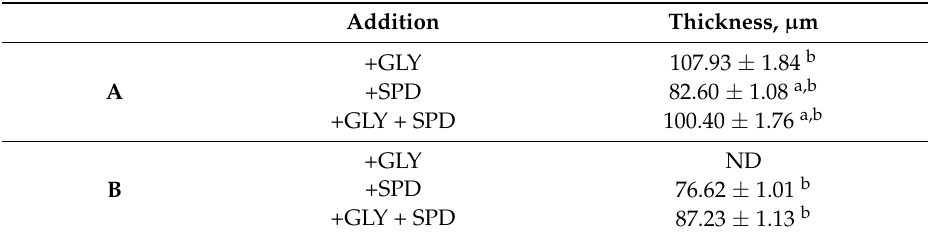
Table 6. Effect of 5 mM SPD and, or 42 mM GLY on the thickness of native (A) and heat-denatured (B) BV protein films obtained at pH 8.0